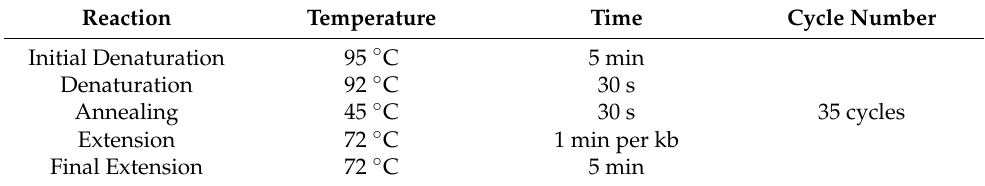
Table 8. Cycling condition for insertion direction